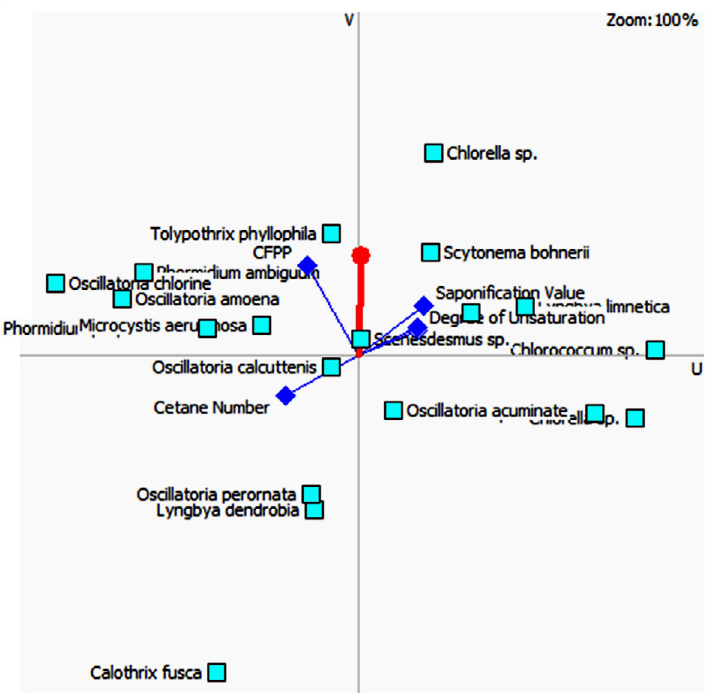
Fig. 2. GAIA plot of one algal species from the current study and eighteen algal and blue-green algal strains from different literature as shown in table no. 1, based on different biodiesel properties from table no. 4 and the decision